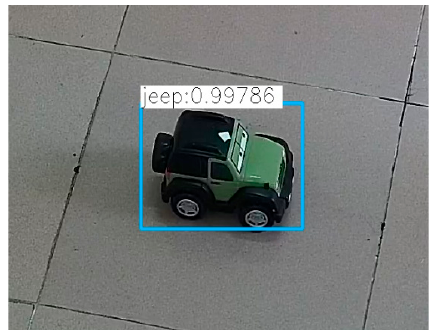
Figure 4. Target detection with